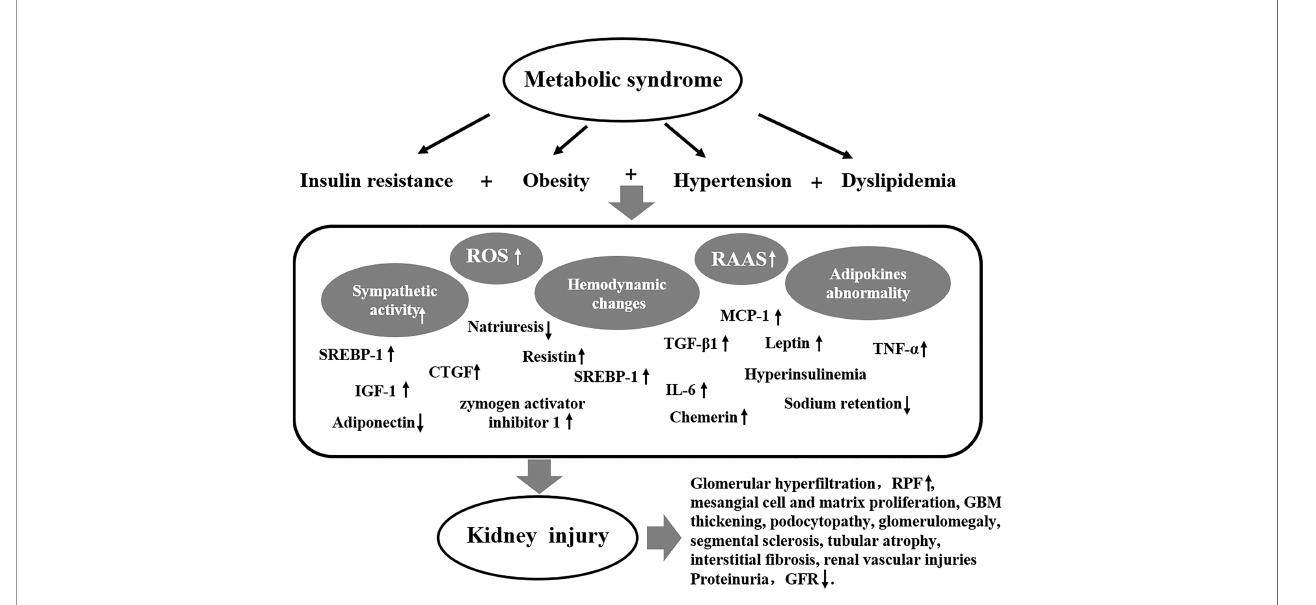
FIGURE 1 | The pathogenesis of MetS-related kidney